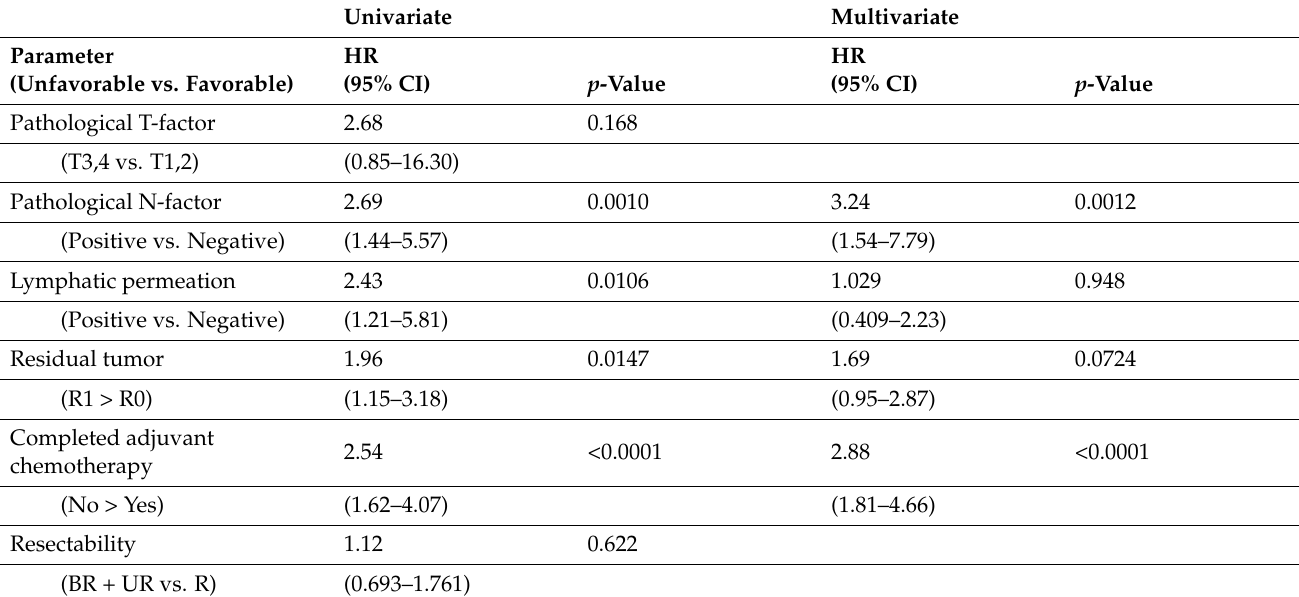
Table 2. Predictive factors for overall survival in surgical